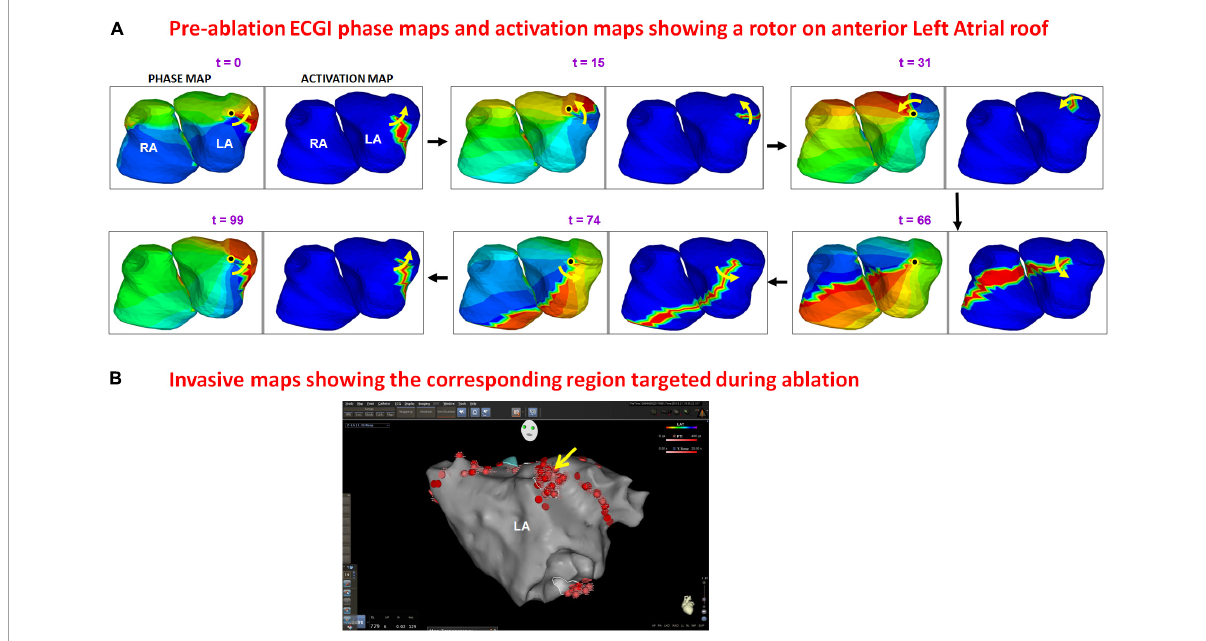
FIGURE6 Panel (A) shows the phase progression maps (left) and corresponding time-domain activation maps (right) for 100 ms of pre-ablation AF. Phase maps show a counter-clockwise rotor (yellow arrow) on the anterior left atrial roof near the left atrial appendage, with its center of rotation (black dot in phase map) anchored on the roof. The activation maps show high-curvature wavefront completing one full rotation around the same region. The patient underwent rotor ablation and PVI. Panel (B) shows the electro-anatomic map of anterior LA obtained during the patient’s ablation. The LA roof region was identified to harbor rotational activity [yellow arrow in panel (B) ] and was ablated (clustered red dots) by the cardiologist who was blinded to the ECGI finding. The red dots in other regions indicate PV isolation ( Supplementary Video 4